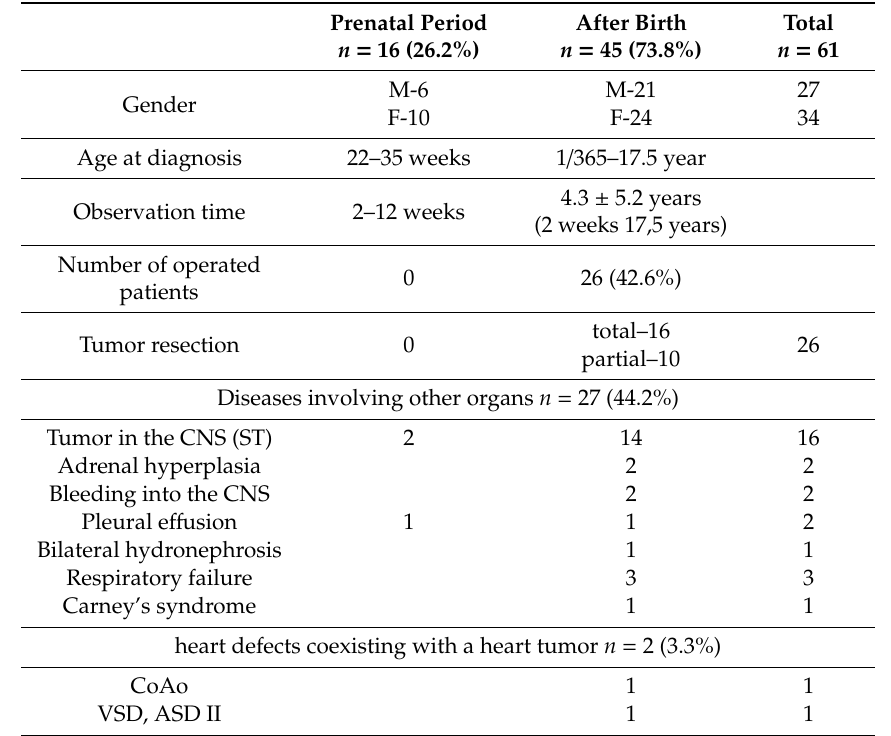
Table 1. General characteristic of the study